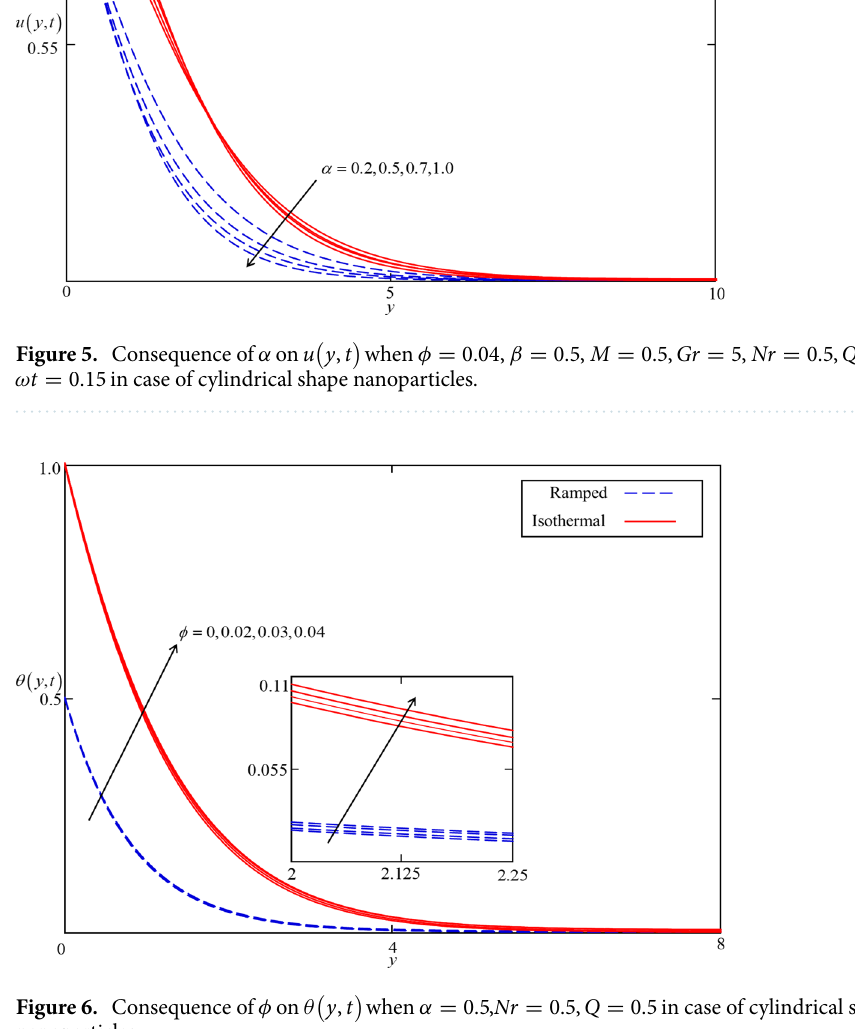
Figure 6. Consequence of φ on θ